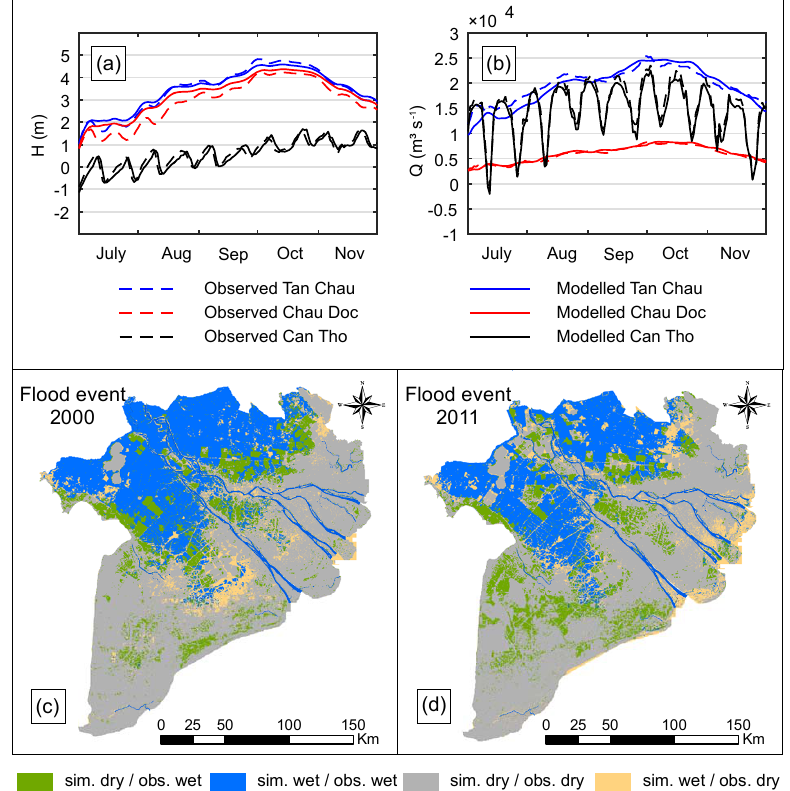
Figure 4. Model performance: comparison of gauged and simulated water level (a) and discharge (b) at stations Tan Chau, Chau Doc and Can Tho for the 2011 flood; comparison of observed data, i.e. derived from satellite, and simulated maximum inundation extent for the floods in 2000 (c) and 2011 (d) . Grey and blue indicate agreement, green means observed inundation but no inundation simulated, and yellow implies simulated inundation but no inundation